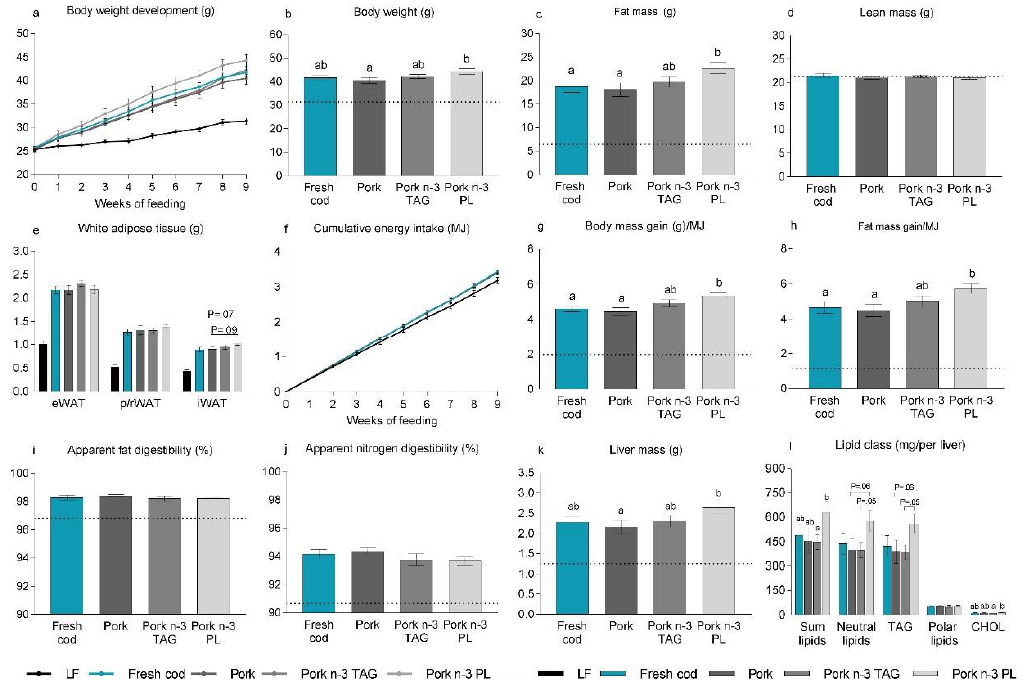
Figure 3. Effects of pork-containing Western diets with added n -3 PUFAs to match the level of n -3 PUFAs in a Western diet containing fresh cod. Male C57BL/6J mice were fed Western diets containing either fresh cod or fresh pork as a protein source for 12 weeks. The two pork diets were supplemented with either TAG-bound (pork n -3 TAG) or PL-bound (pork n -3 PL) EPA+DHA at levels matching the content of the fresh cod-containing diet. As reference, a group of low fat (LF)-fed mice ( n = 5) was included and is shown as a dotted line. ( a ) Body weight development was determined and is shown for the first 9 weeks of feeding. ( b ) Body weight was measured and ( c ) fat and ( d ) lean mass were determined using nuclear magnetic resonance after 9 weeks of feeding. ( e ) Epididymal white adipose tissues (eWAT), inguinal white adipose tissues (iWAT) and perirenal/retroperitoneal white adipose tissues (p/r WAT) were dissected out after 12 weeks of feeding and their masses were recorded. ( f ) Feed intake was recorded continuously, and cumulative energy intake (MJ) was determined and is shown for the first 9 weeks of feeding; ( g ) After 9 weeks of feeding, the amount of body mass gained per energy unit consumed and ( h ) fat mass gained per energy unit consumed were calculated; Apparent ( i ) fat and ( j ) nitrogen digestibilities (%) were calculated based on feed intake and feces collected during the 6th week of feeding; ( k ) After 12 weeks of feeding, livers were dissected out and weighed ( l ). Lipids were extracted from livers ( n = 7) and total lipids, neutral lipids, triacylglycerol (TAG), polar lipids and cholesterol (CHOL) were quantified, and results are presents as mg lipids per liver (mg lipids/g liver × liver weight (g)). Data are presented as means ± SEMs ( n = 14–15), except for the lipid class analysis ( n = 7) and were analyzed using one-way ANOVA followed by Fisher’s LSD post hoc tests. Cumulative energy intake was analyzed by repeated measures ANOVA and Fisher’s LSD post hoc tests. Different letters denote statistical significance ( p ≤ 0.05) between the